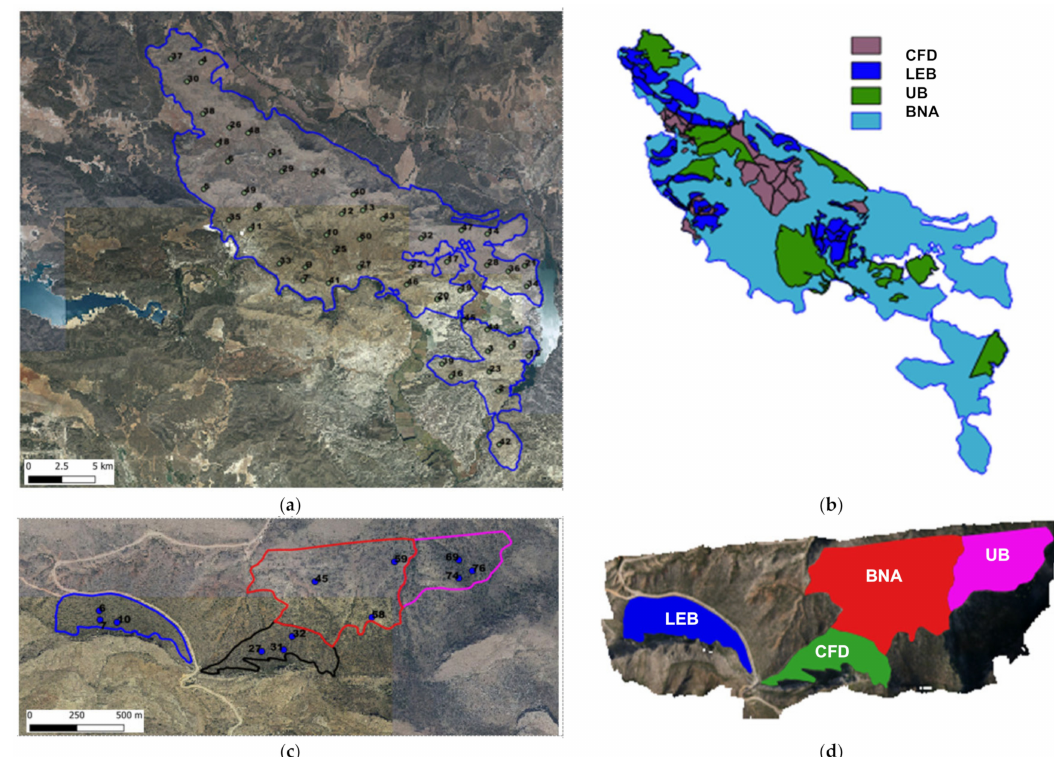
Figure 2. Plot location and distribution of soil conditions in the catchment ( a , b ) and hillslope ( c , d ) areas in Sierra de los Donceles forest (Castilla La Mancha, Spain). Log erosion barriers (“LEB”), contour-felled log debris (“CFD”), burned and no action (“BNA”), unburned (“UB”).